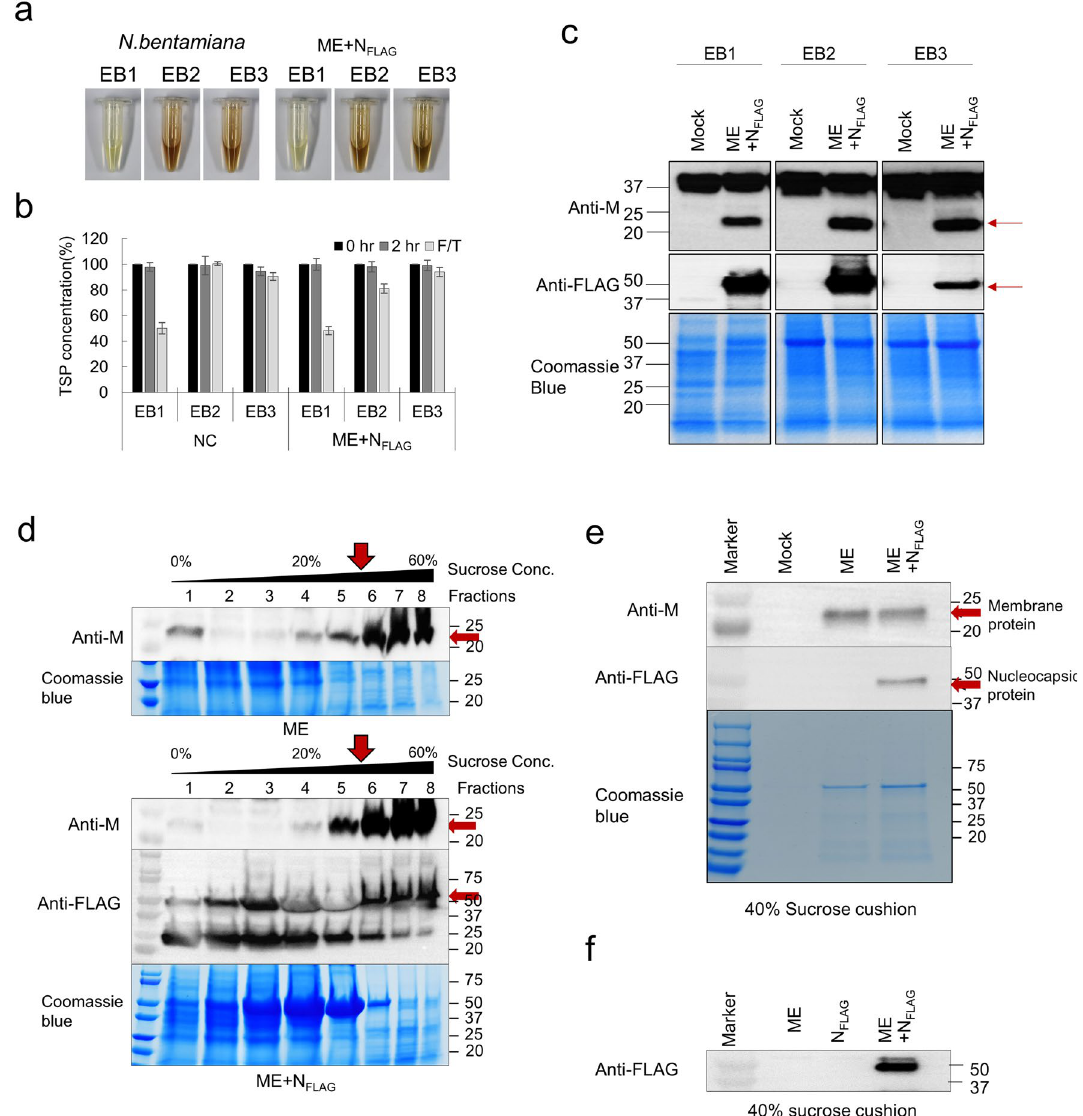
Figure 2. ( a – c ) Effect of TSP extraction by protein extraction buffer. Comparison of solution states ( a ) and TSP concentrations ( b ) extracted from infiltrated leaves using three protein extraction buffers EB1 (PBS, EDTA, and 2-mercaptoethanol), EB2 (PBS and EDTA), and EB3 (only PBS). The TSP concentration was measured 2 h after extraction (2 h) or the sample thawed after freezing (F/T). Values are the means ± SE of three independent biological replicates. ( c ) Western blot analysis of M protein (25 kDa) and N protein (46 kDa) expression in TSP extracted by three extraction buffers. ( d ) The purification conditions of plant-derived VLPs were confirmed through 10–60% sucrose gradient sedimentation of ME and ME + N FLAG TSP. M protein and N protein were observed in about 40% sucrose layer by western blot analysis with M and FLAG antibodies. ( e ) Identification of M and N proteins from VLPs purified by 40% sucrose cushion in TSP of ME and ME + N FLAG . ( f ) Presence of N protein after purification of VLPs using 40% sucrose in N FLAG single expression and ME + N FLAG co-expression. All images were cropped. See Supplementary Figs. S4–S7 for full size of SARS-CoV-2 VLPs derived from mammalian or insect expression systems were detected in fraction of 30–40% sucrose concentration 26,27 , and these results were consistent with our purification conditions. Without the S glycoprotein in our constructs, the usual SARS-CoV-2 ‘crown’ was not detected in TEM images. Sizes of assembled particles were in the range of 50–130 nm with an average of 75.20 ± 19.72 nm (Fig. 3b). Previous studies revealed a particle size distributes with a median of about 100 nm without spikes 28 . VLPs without S protein expressed in HEK-293 T human cells or Vero E6 animal cells were 90.33 ± 32.45 nm and 71.02 ± 21.98 nm 27 , respectively. Therefore, in our results, it was confirmed that the shape and size of plant-derived VLPs were similar to those of native SARS-CoV-2 VLPs without spike. Through this study, we confirmed for the first time that the three important proteins of the SARS-CoV-2 successfully form VLPs structures in plant cells. Since we did not include the S protein, it differs from many